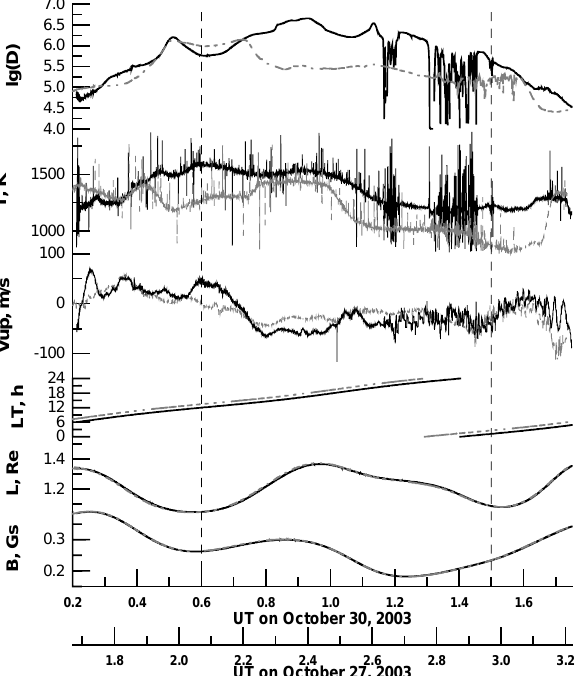
Fig. 4. The same as in Fig. 3 but for storm-time disturbances on 30 October 2003 and quiet conditions on 27 October